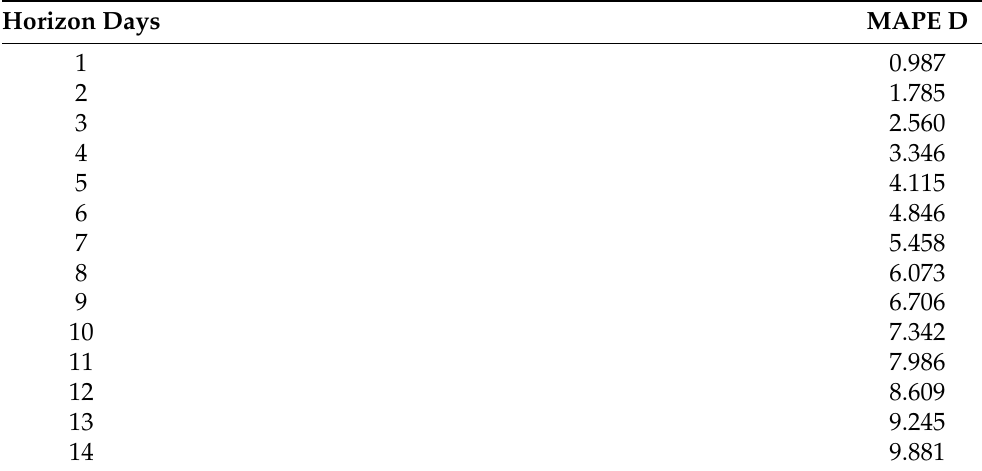
Table 5. MAPE D-Aggregation training without Abruzzo, Basilicata, Lazio and Molise without stringency